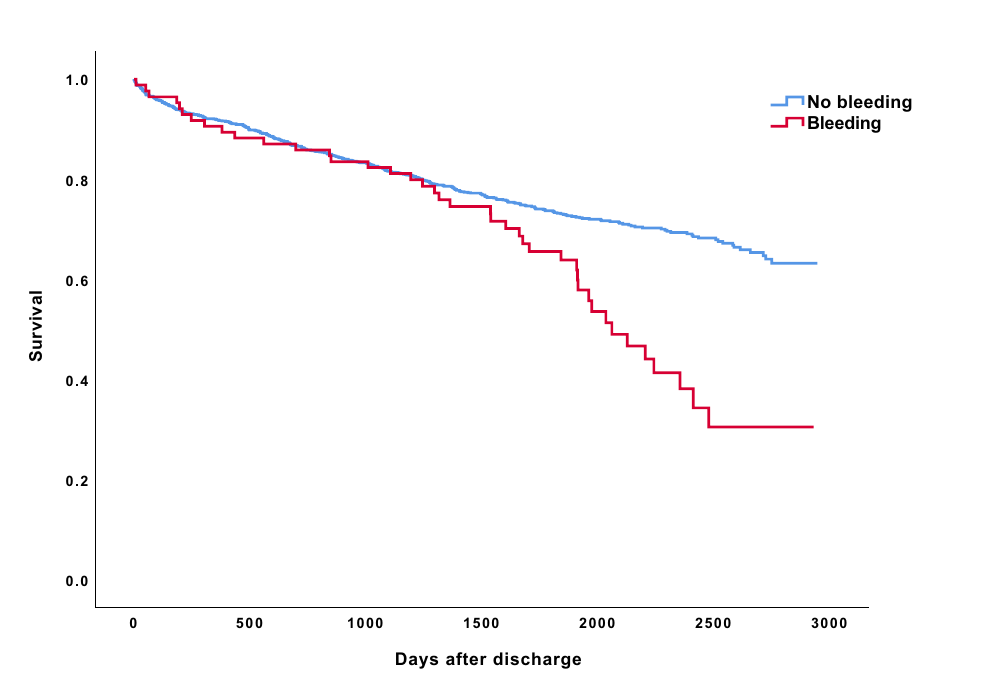
Figure 4. Cumulative survival after ACS, stratified by